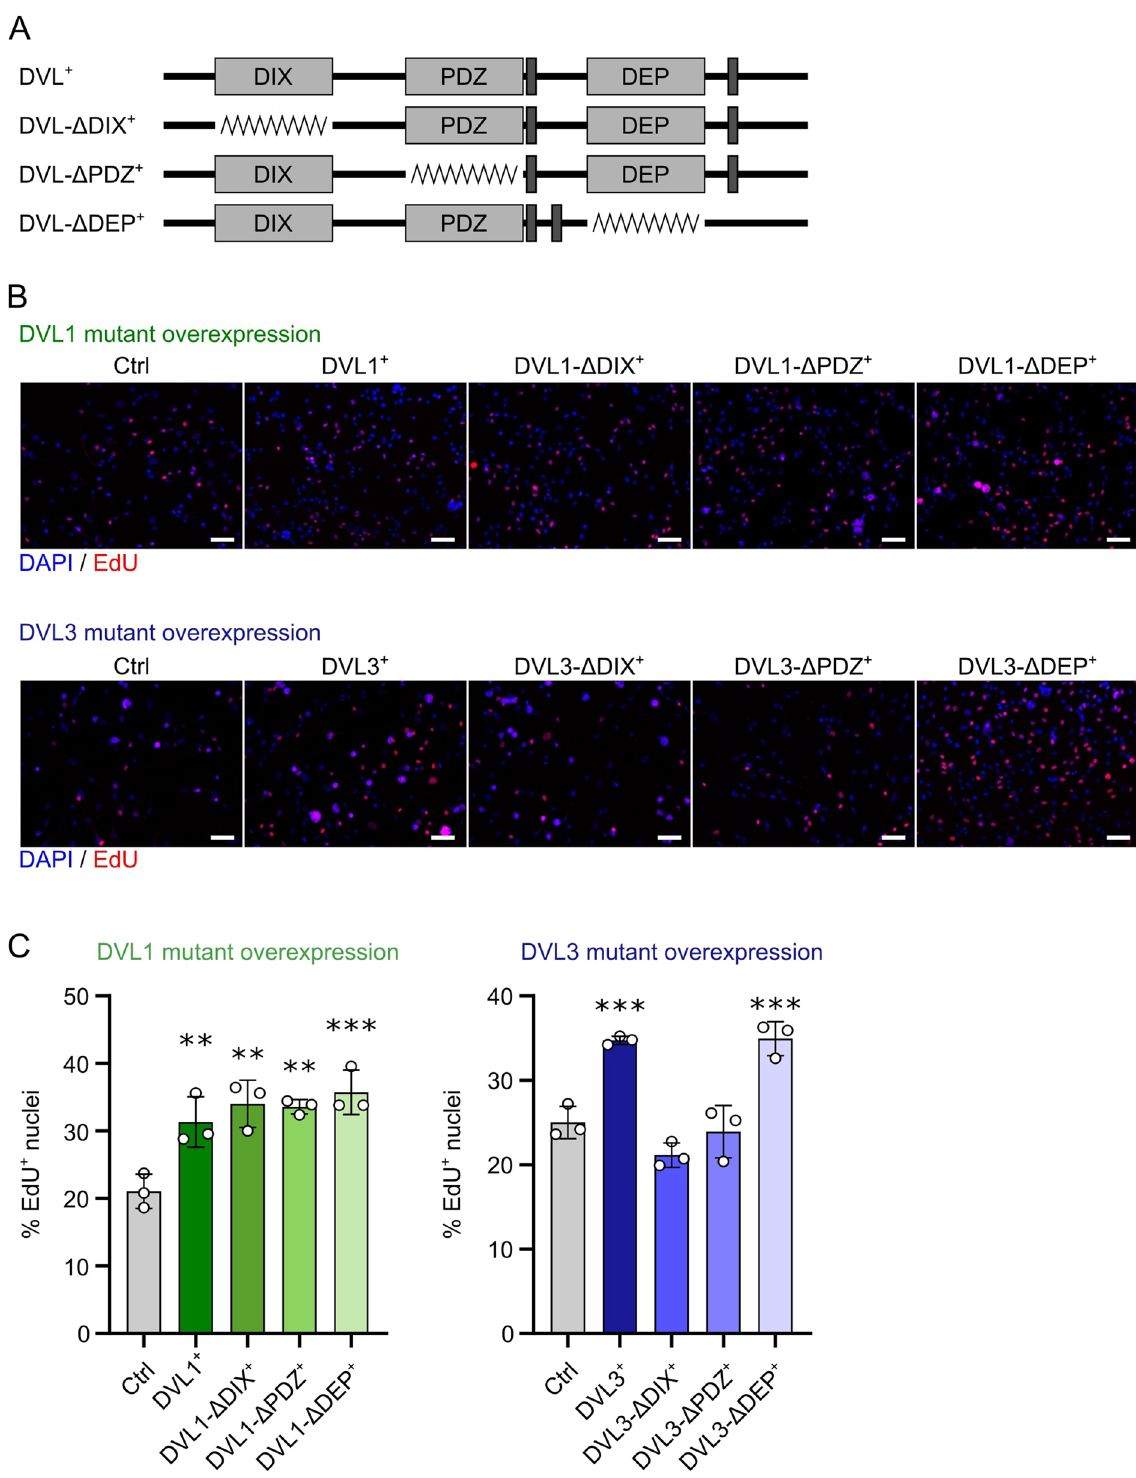
Figure 7. Deleting conserved domains in DVL1 or DVL3 has different effects on myoblast proliferation. ( A ) Schematic representation of the relative positions of the DIX, PDZ and DEP domains in full-length DVL protein and the respective domain deletion mutants. ( B ) Representative images of proliferating C25 myoblasts with stable overexpression (> 1 week) of wild type DVL1 + or DVL3 + and their respective mutants. An EdU pulse was performed 24 h after seeding stably overexpressing myoblast lines. Proliferating myoblasts with incorporated EdU (red), and all nuclei counterstained with DAPI (blue) are shown. Scale bar represents 100 µm. ( C ) Quantification of proliferation rates after overexpression of DVL1 or DVL3 and their respective mutants. A statistically significant difference was calculated using a One-Way ANOVA with Dunett’s post-test, comparing each sample to the control, where 2 asterisks denotes p < 0.01 and 3 asterisks denotes p < 0.001. Quantification was performed for 3 biological